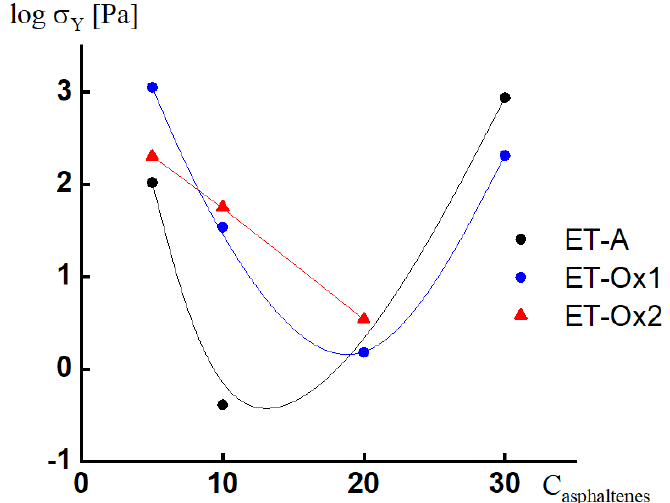
Figure 5. Concentration dependence of the yield stress of paraffin dispersions containing fillers.